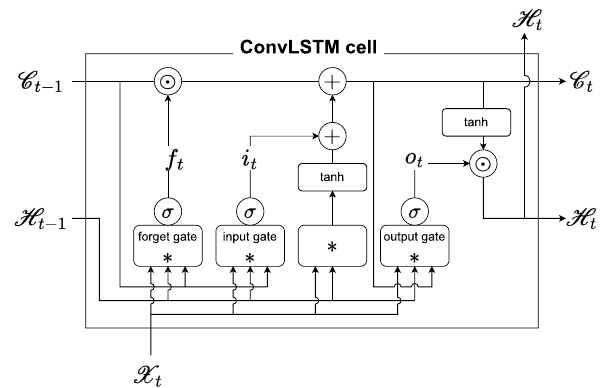
Figure 3. ConvLSTM